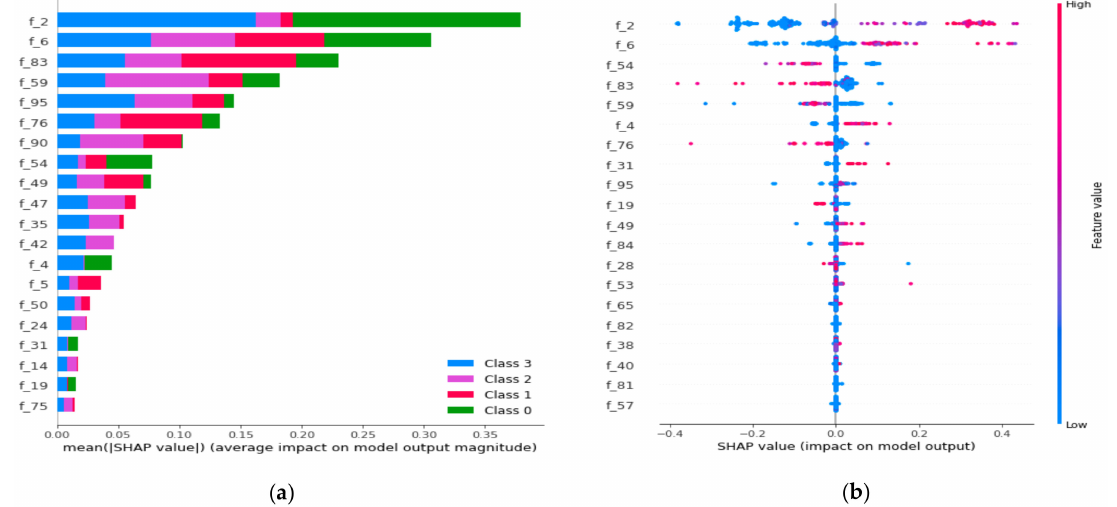
Figure 10. ( a ) The proposed model’s feature importance, using the random forest for four classes; ( b ) the feature importance impact, using SHAP library, shows high and low